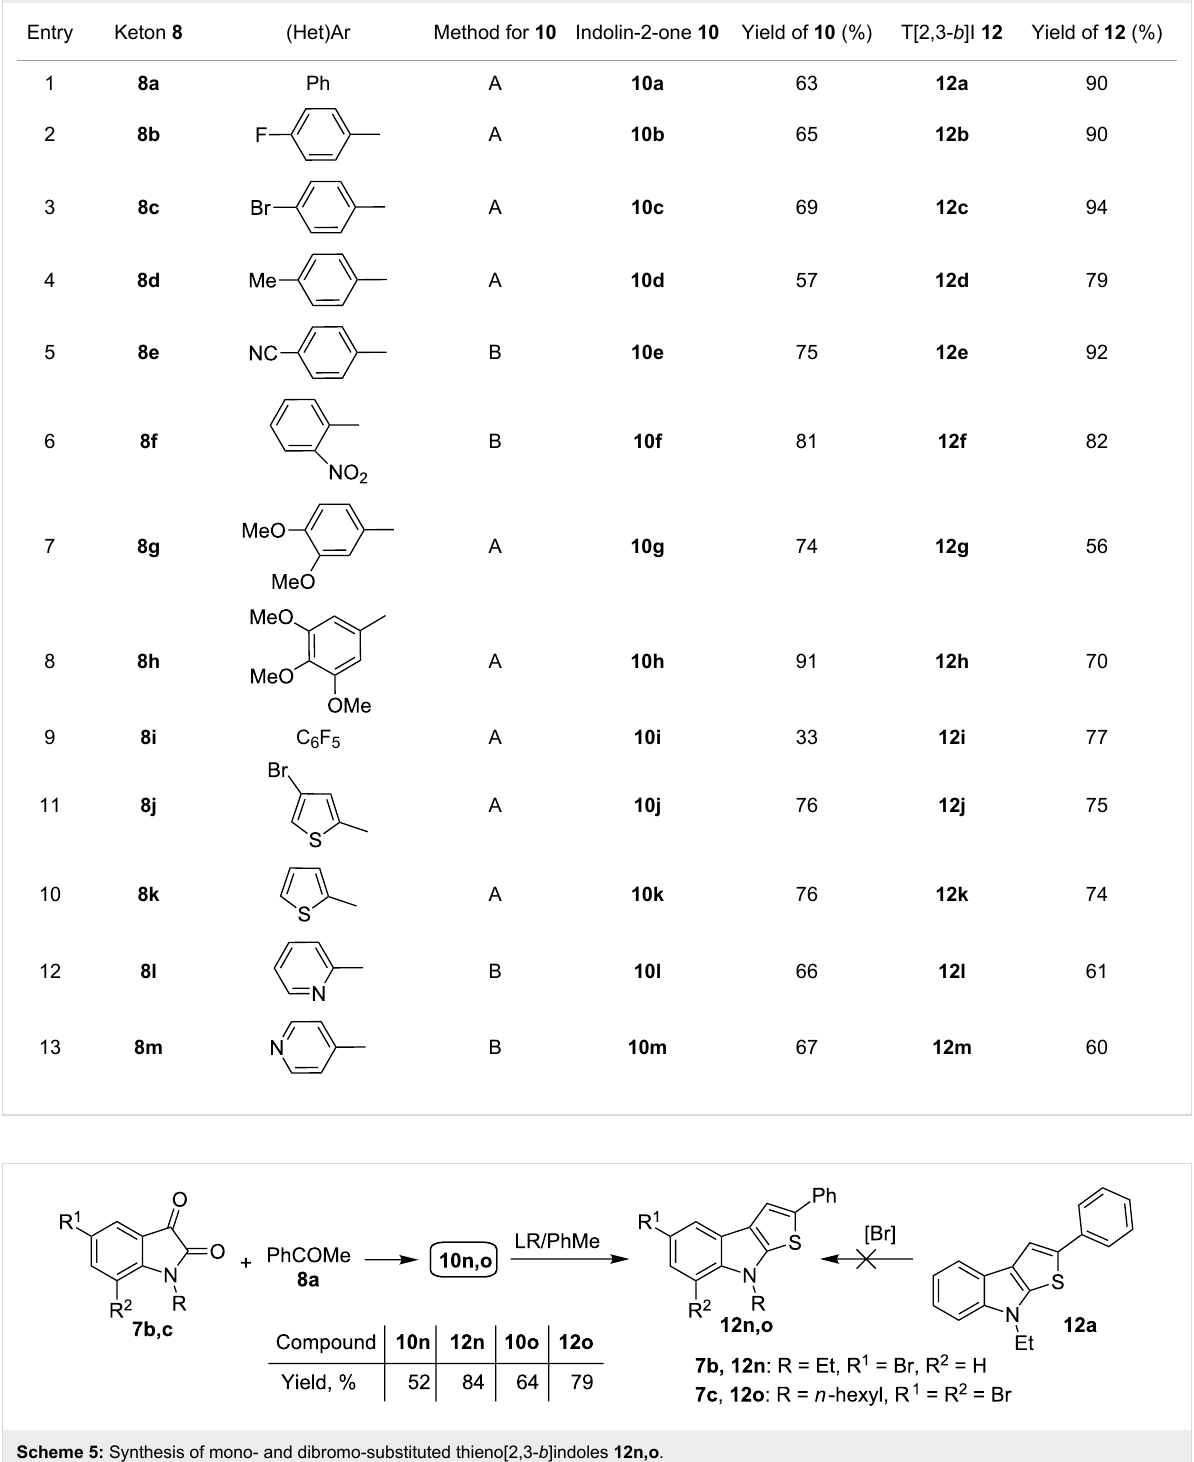
Table 1: Yields of thieno[2,3- b ]indoles (T[2,3- b ]I) 12 and their precursors 10